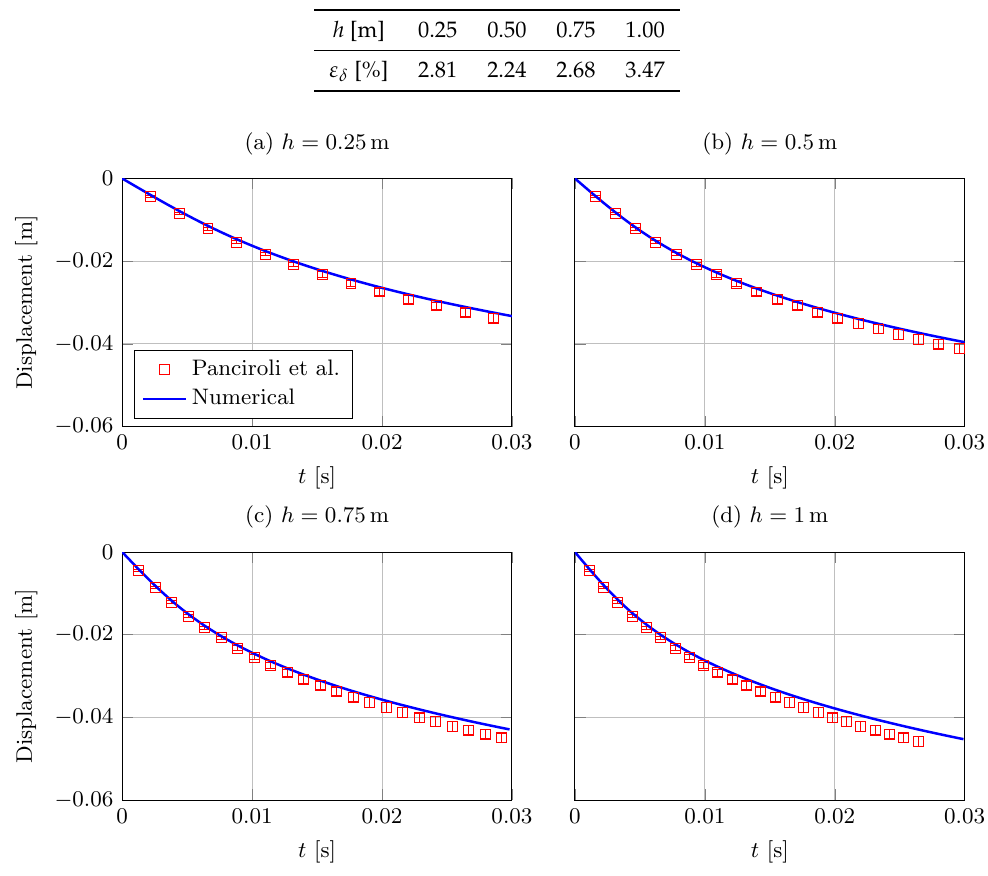
Table 1. Relative average error evaluated comparing δ CFD and δ EXP .